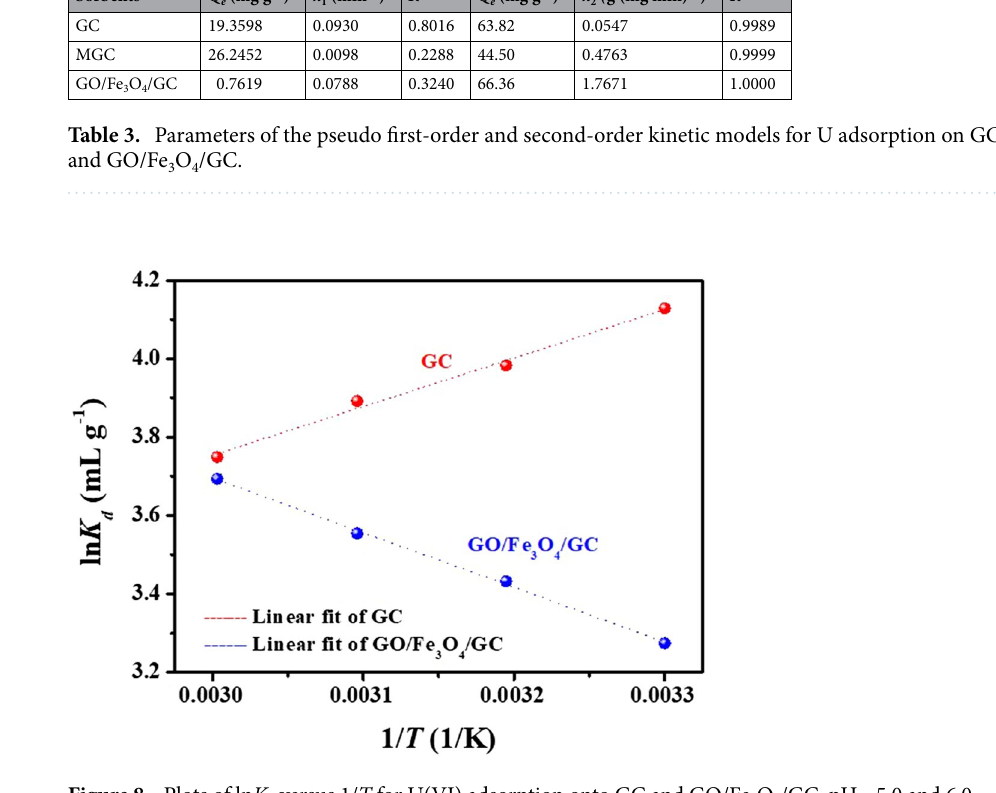
Figure 8. Plots of ln K d versus 1/ T for U(VI) adsorption onto GC and GO/Fe 3 O 4 /GC. pH = 5.0 and 6.0, C